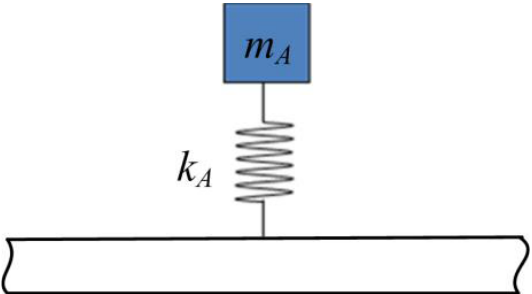
Figure 5. A host beam with a transverse-force type resonator. (Reprinted from Ref. [34].).